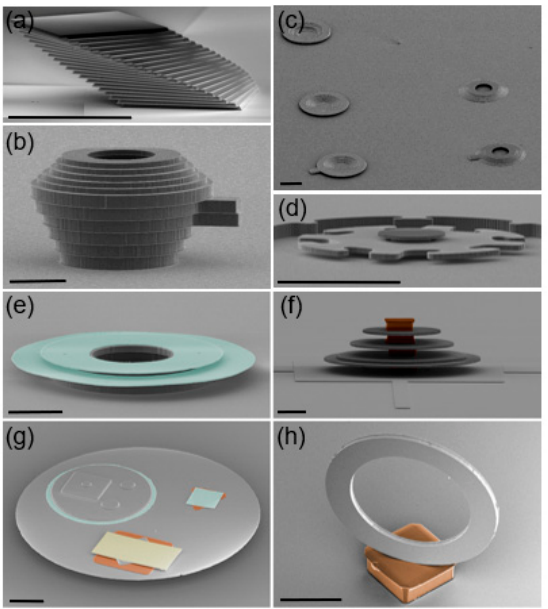
Figure 9. Colored SEM images of micro-LEGO-assembled Si (grey), SiO 2 (green), Au (yellow), and SU8 (brown). Images of ( a ) multilayer configurations of thin Si platelets in a single stack with small incremental rotations and translations, ( b ) stacked thick Si rings with varied thickness and diameter, ( c ) stacked thin Si rings with varied diameter, ( d ) an assembled micromotor representation, ( e ) double layer Si rings and SiO 2 discs, ( g ) a microstructure composed of Si, SiO 2 , Au, and SU8 pieces, ( f ) a multiple layer Si discs and SU8 blocks, and ( h ) a vertically aligned Si ring joined on a SU8 block. All scale bars represent 100 m. Reproduced with permission from